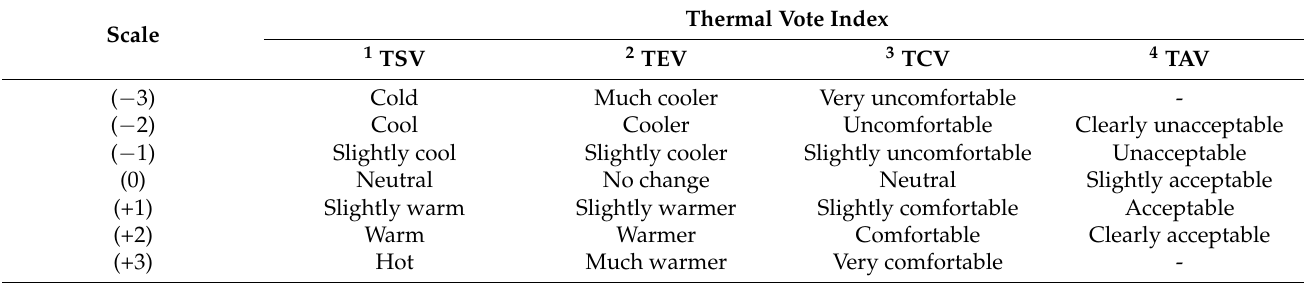
Table 4. The scales of occupants’ subjective thermal